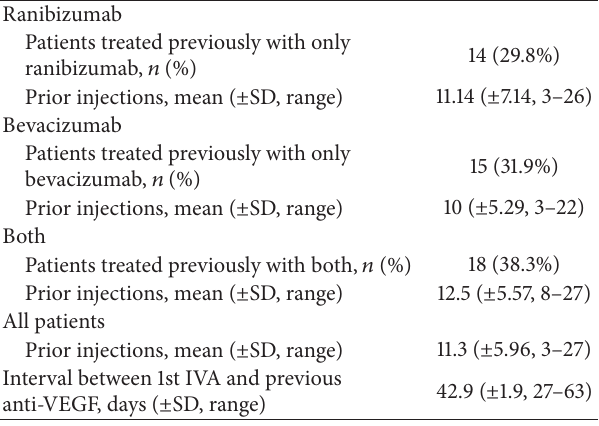
Table 2: Injection history prior to aflibercept conversion.